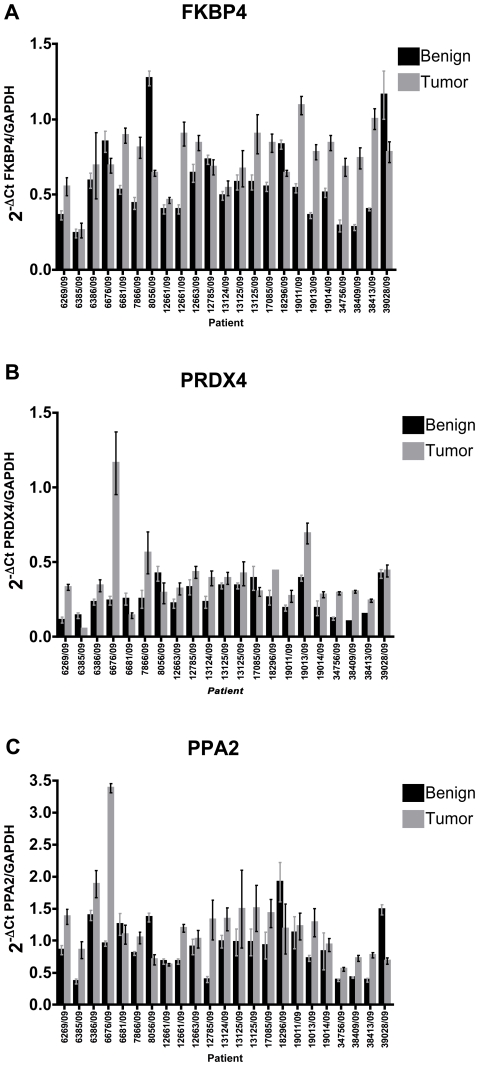
Expression of several protein candidates is regulated at transcriptional level.Quantitative reverse transcription-PCR of transcripts (A) FKBP4, (B) Prdx4 and (C) PPA2 shown from benign prostate tissue (black bars) and localized prostate cancer (grey bars). For statistical significance unpaired student t-test performed at 95% CI and p value<0.05 was considered as significant.